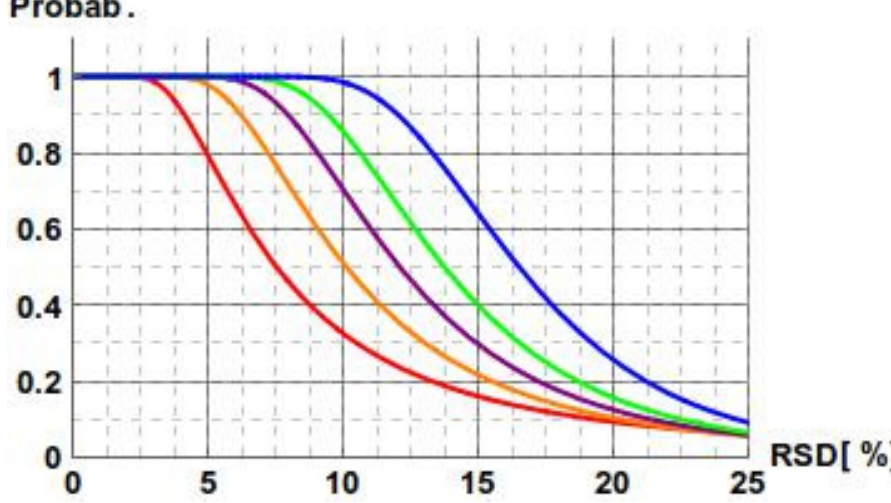
Figure 4. Dependence of the probability that the confidence interval width is below 30% on the precision in measurements. Equal precision for the reference and the studied measurements is assumed. Curves are defined for n = 3 (red), n = 4 (orange), n = 5 (purple), n = 6 (green), and n = 8